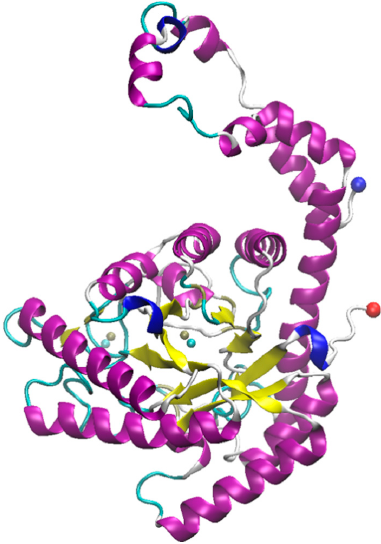
Figure 6. 3D Structure of glucose isomerase from Streptomyces rubiginosus . The crystal structure was solved by Dauter and coworkers; downloaded from rcsb.org (1OAD) [145,199] The structure was visualized using VMD. The N- and C-termini are shown as red and blue spheres respectively while the manganase ions are shown in tan and the magnesium ions shown in cyan. The structure represents one monomer of a